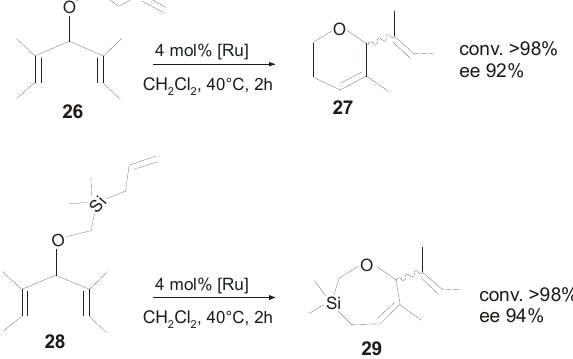
Scheme 7. Asymmetric ring closing metathesis of 26 and 28 catalyzed by 21- anti GII